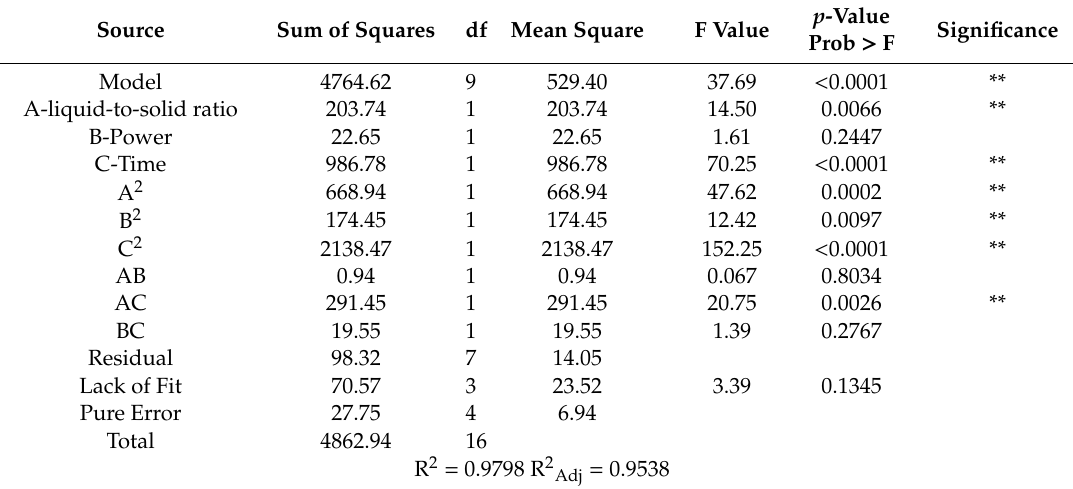
A-liquid-to-solid